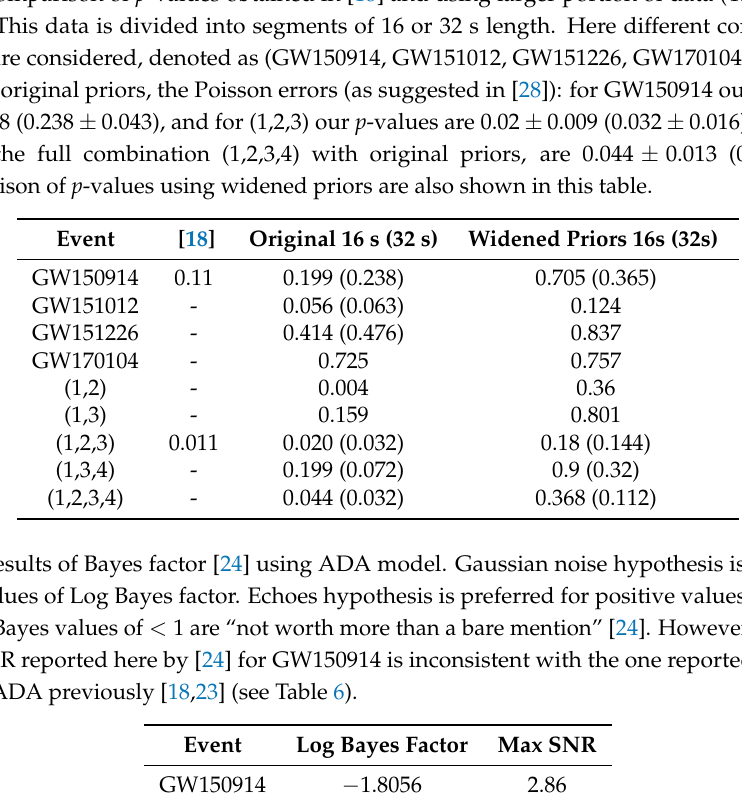
( 1,2,3,4 ) . → 0.009 (0.032 0.016). The Poisson ± ± 0.013 (0.032 0.016). ± ±